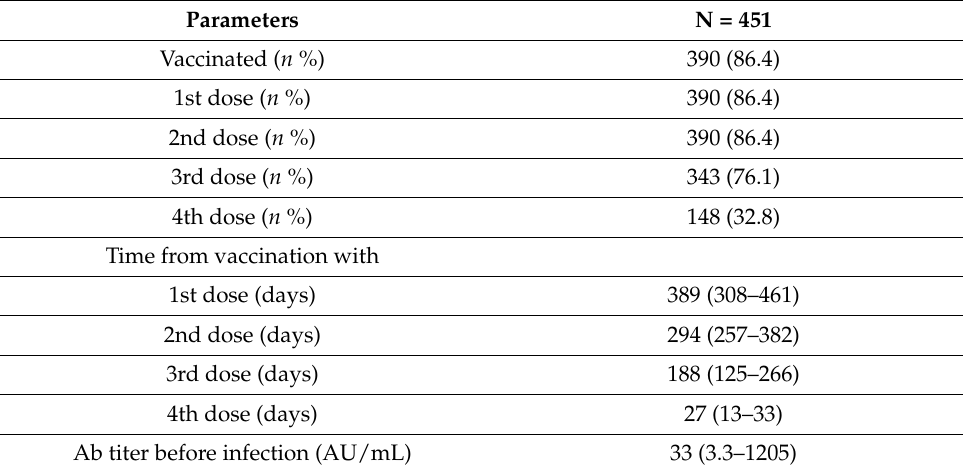
Table 2. Vaccination status and SARS-CoV-2 serology in the study population. Parameters N =